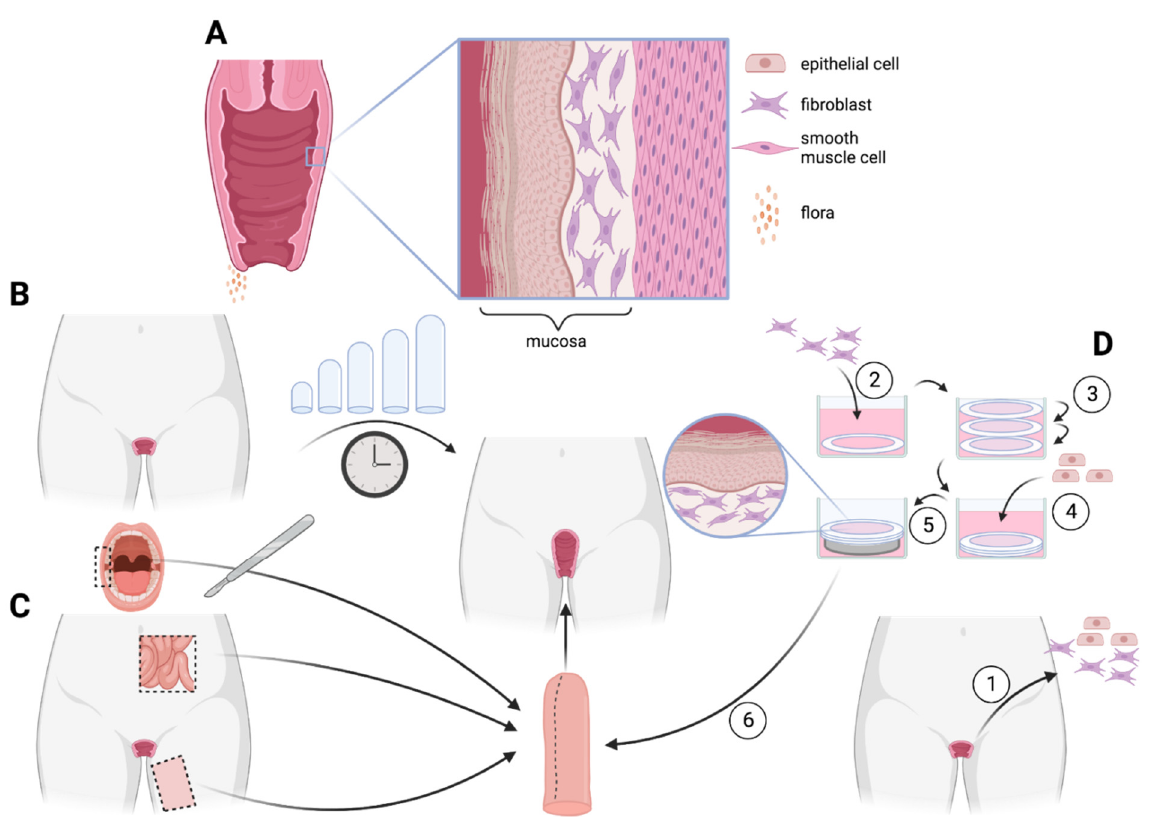
Figure 4. Neovagina construction by techniques: ( A ) Histoanatomy of the vagina. The glycogenated stratified squamous epithelium lines the vaginal lumen, sitting on a stroma. These two layers form the vaginal mucosa, which is followed by the muscularis with shared origin as the uterus. ( B ) Vaginal dilation, Frank’s method, is the gold standard of treatment for MRKH patients. ( C ) Surgical treatments rely on heterotopic autografts. ( D ) Tissue engineering may allow for au- tologous vaginal mucosa formation in MRKH patients. After vaginal cell extraction (1), the “self-assembly” method is relying on fibroblasts which secrete ECM components when treated with ascorbic acid (2). ECM sheets are piled, fused, (3) and seeded with epithelial cells for native-like autologous vaginal tissue in vitro (4). The constructs are placed at the air/liquid interface to allow epithelial differentation (5) and once matured, it can be grafted into patient (6). This figure was created with BioRender.com and modified from Brownell et al. [282].